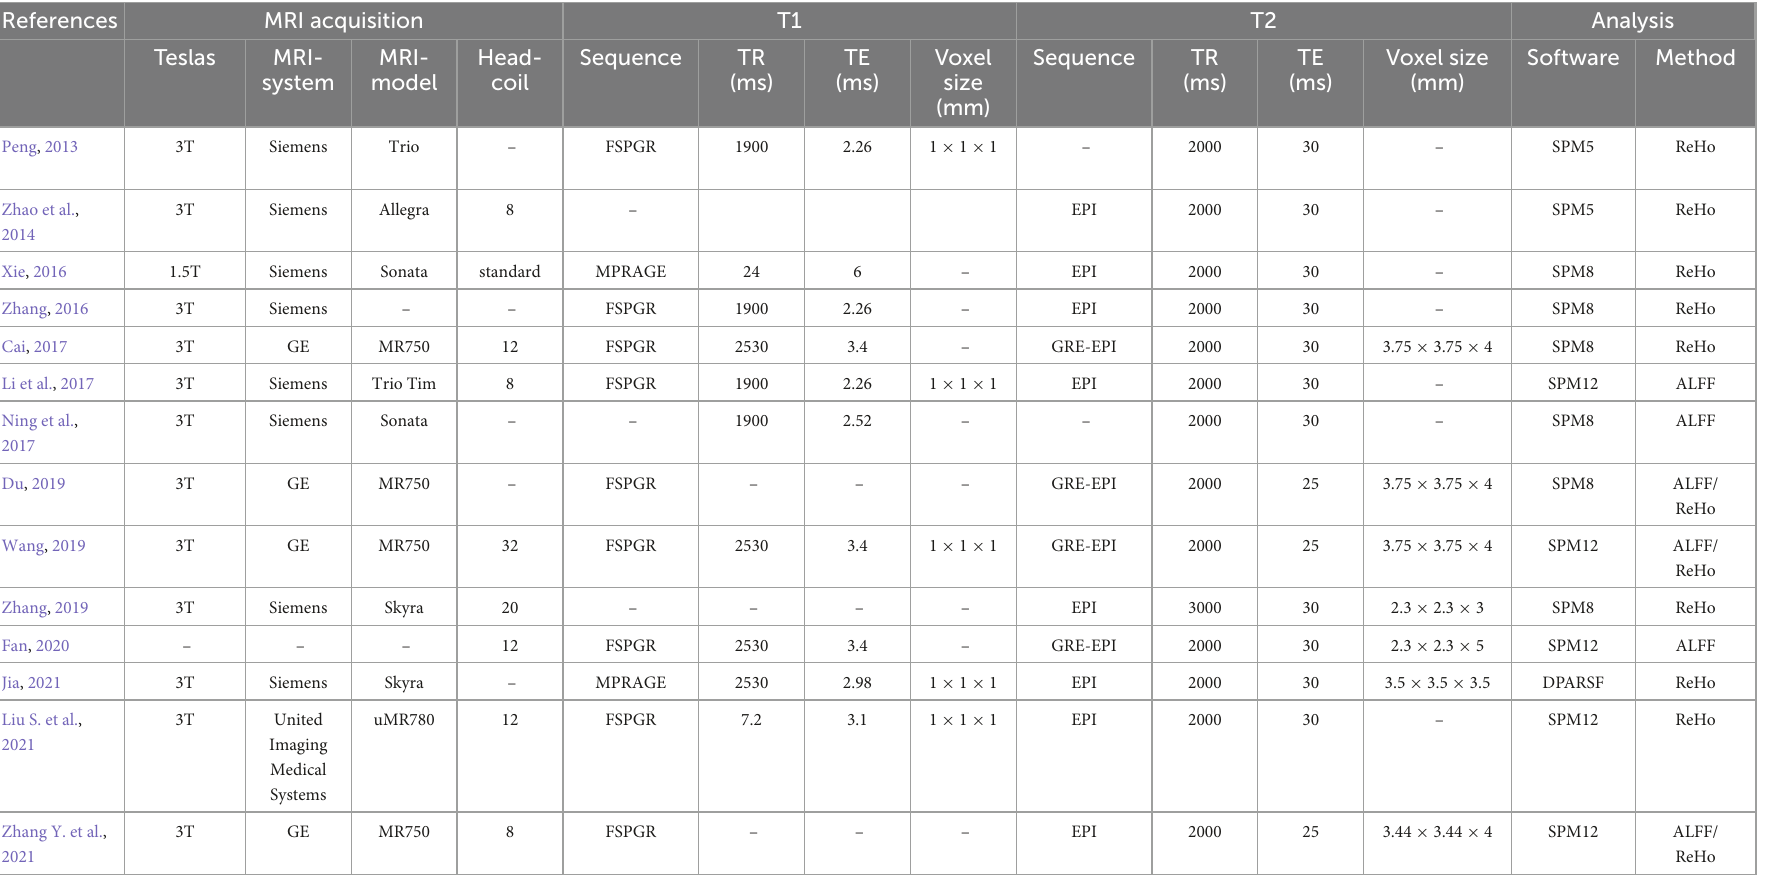
TABLE 3 The details of MRI acquisition and